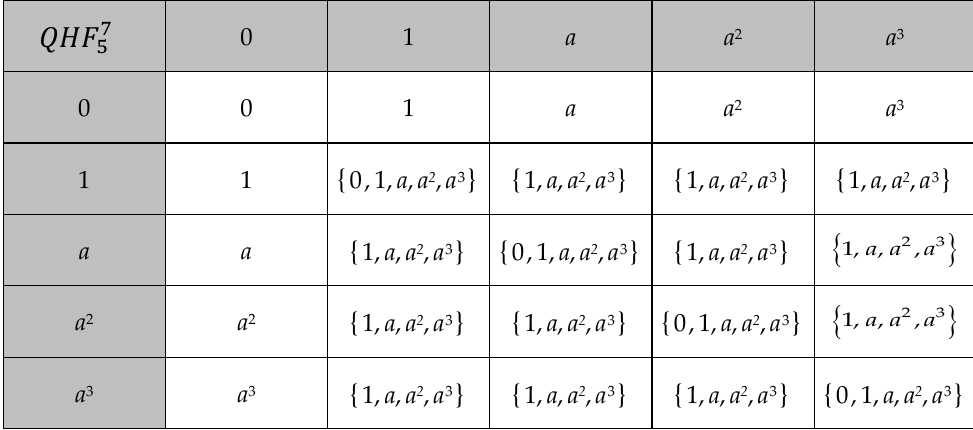
Table 19. The Cayley table of the additive canonical hypergroup of the augmented hyperfield of QHF 4 , QHF 5 and QHF 6 which is simultaneously the additive hypergroup of the quotient hyperfield 5 5 5